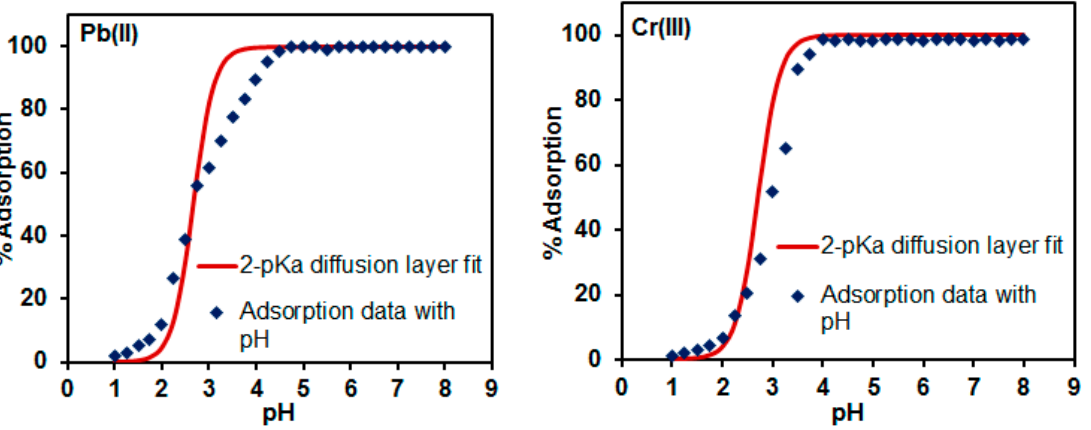
Figure 7. 2-pKa-diffusion layer model fitting of the adsorption data with pH for Pb(II) and Cr(III) onto rGONF.